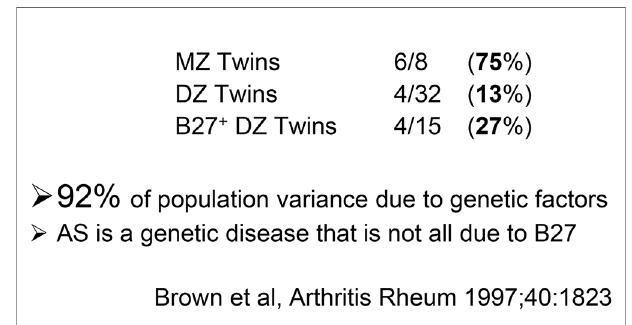
FIGURE 2 | Studies of concordance for AS in UK twins recruited through the National Ankylosing Spondylitis Society. The clear difference on concordance rates between MZ twins and DZ twins is highly indicative of a major genetic component, which can only partly be explained by the in fl uence